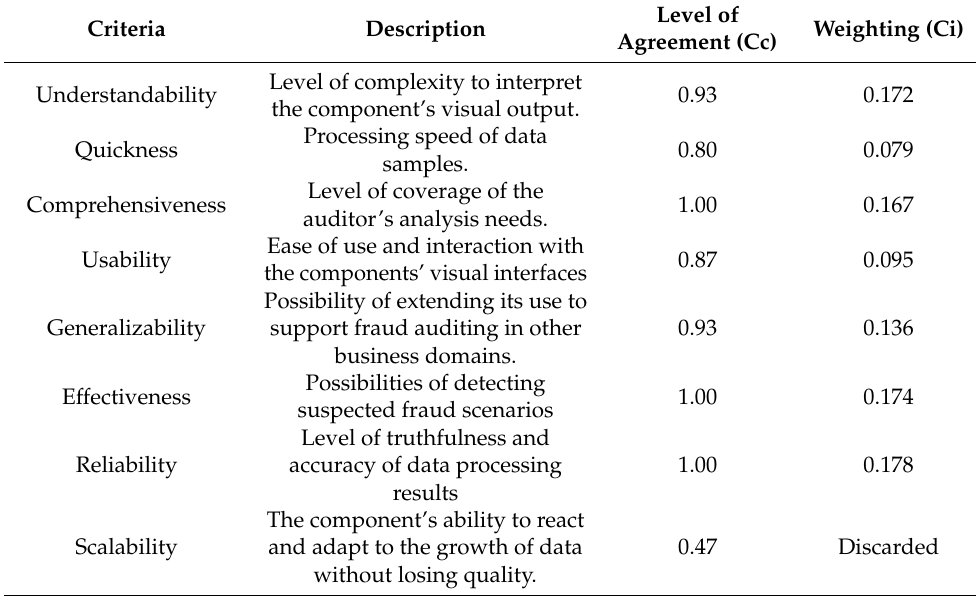
Table 1. Kendall’s coefficient of concordance. Coef (Kendall’s coefficient of concordance), Chi-Sq (chi-square statistic), DF (degrees of freedom), p ( p -value). Coef Chi-Sq DF p 0.826866